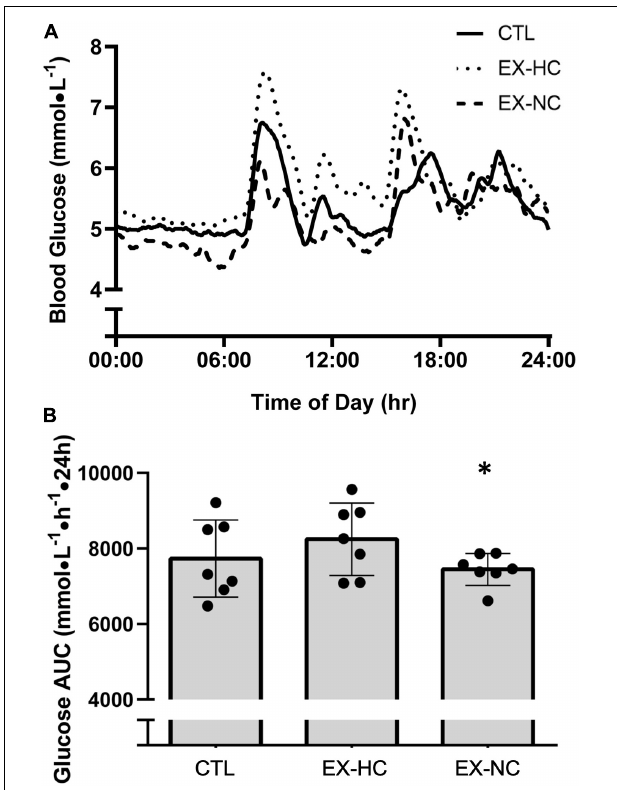
FIGURE 3 | 24 h blood glucose concentrations from 00:00 to 23:59 h, measured the day following seated control (CTL) or a single session of HIIE with carbohydrate-energy replacement (EX-HC) or deficit (EX-NC) (A) . Glucose AUC over the 24 h measurement period during experimental conditions (B) . *Significant difference from EX-HC ( p < 0.05); Values are expressed as means ± SD